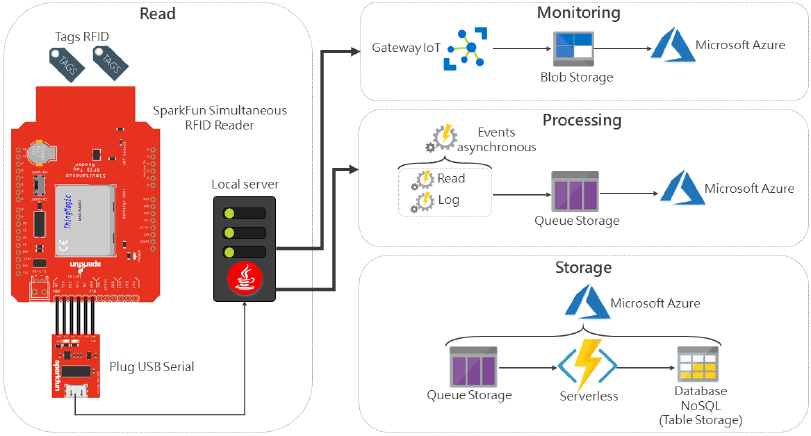
Figure 3. Architecture of Internet of Things